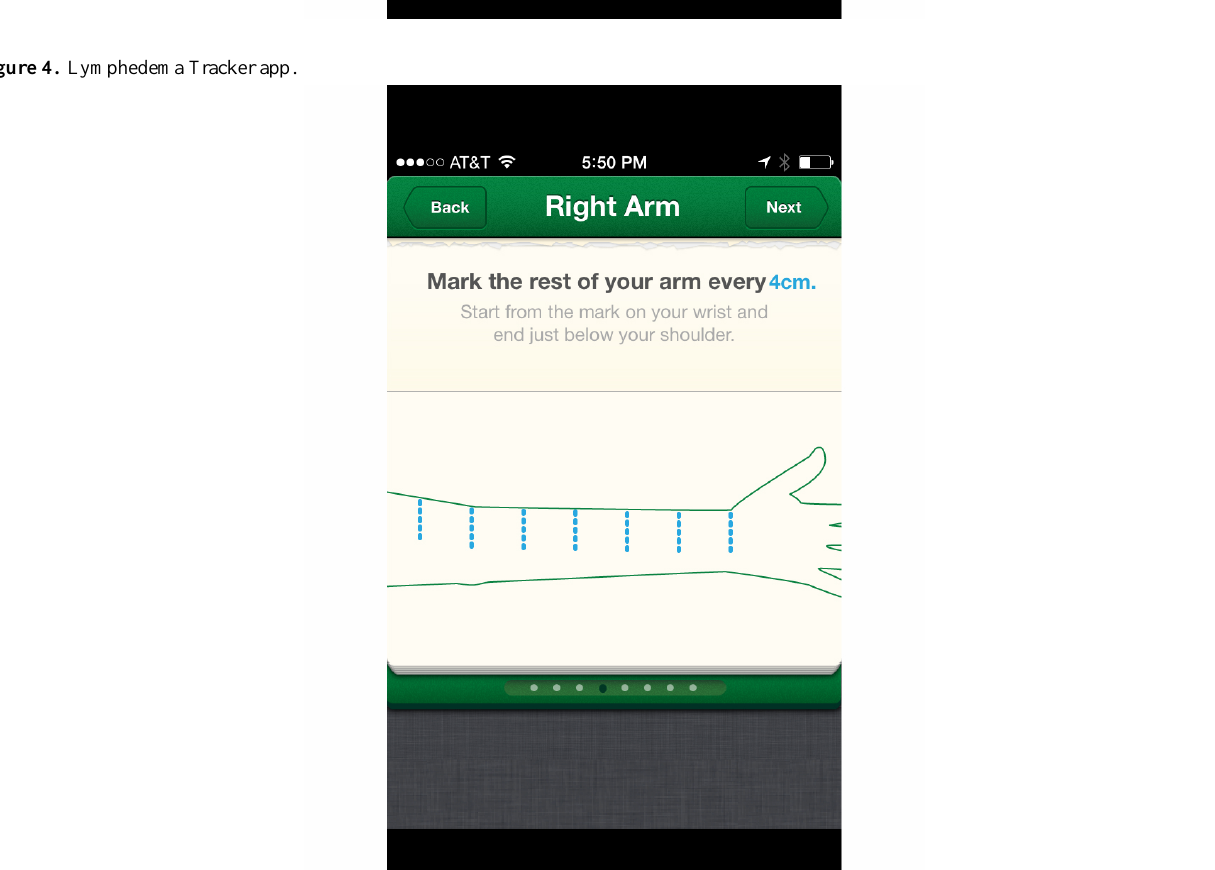
Figure 4. Lymphedema Tracker